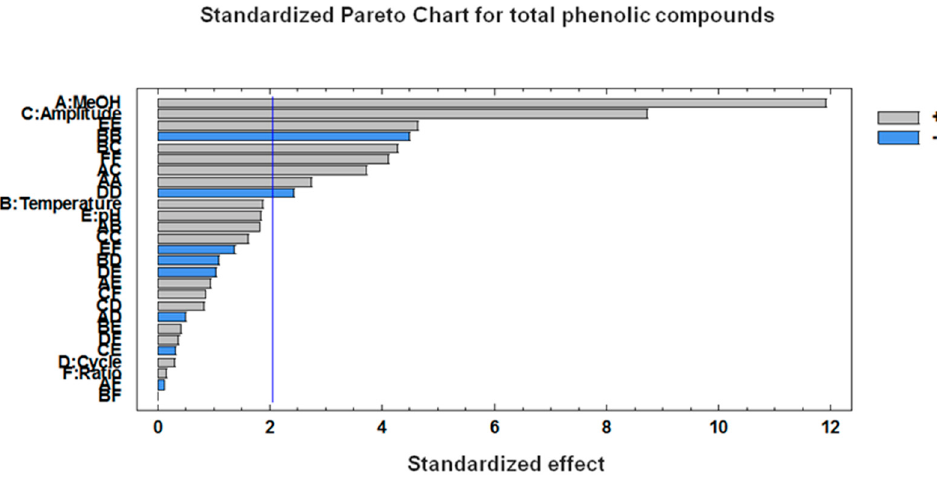
Figure 1. Pareto chart for the standardized effect of the variables on the UAE of phenolic com-